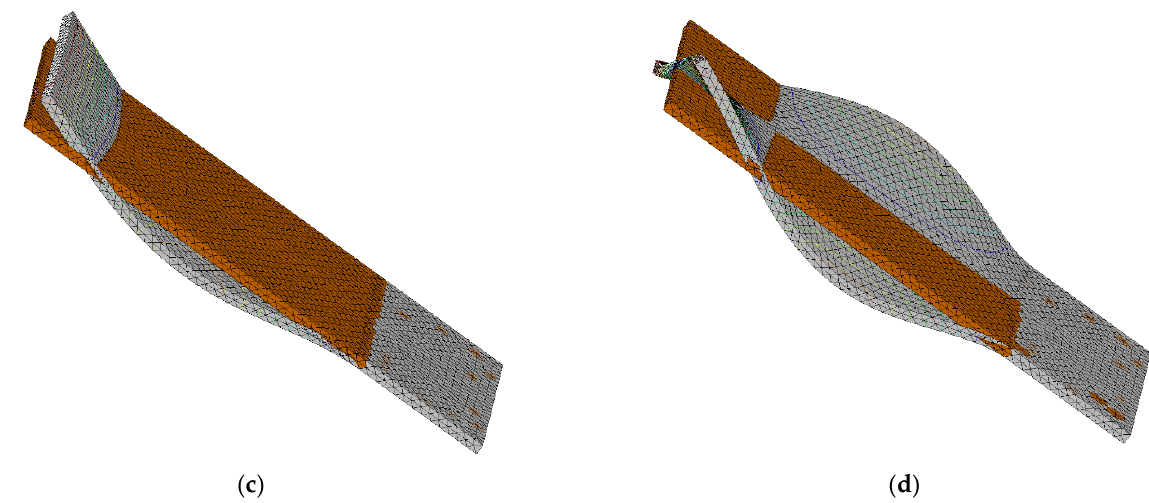
Figure 3. Mode shape of finite element (FE) model of simple specimens (gray color) overlapped with original model (orange color): ( a ) first mode (1st bending); ( b ) second mode (1st twisting); ( c ) third mode (2nd bending); ( d ) fourth mode (2nd twisting).